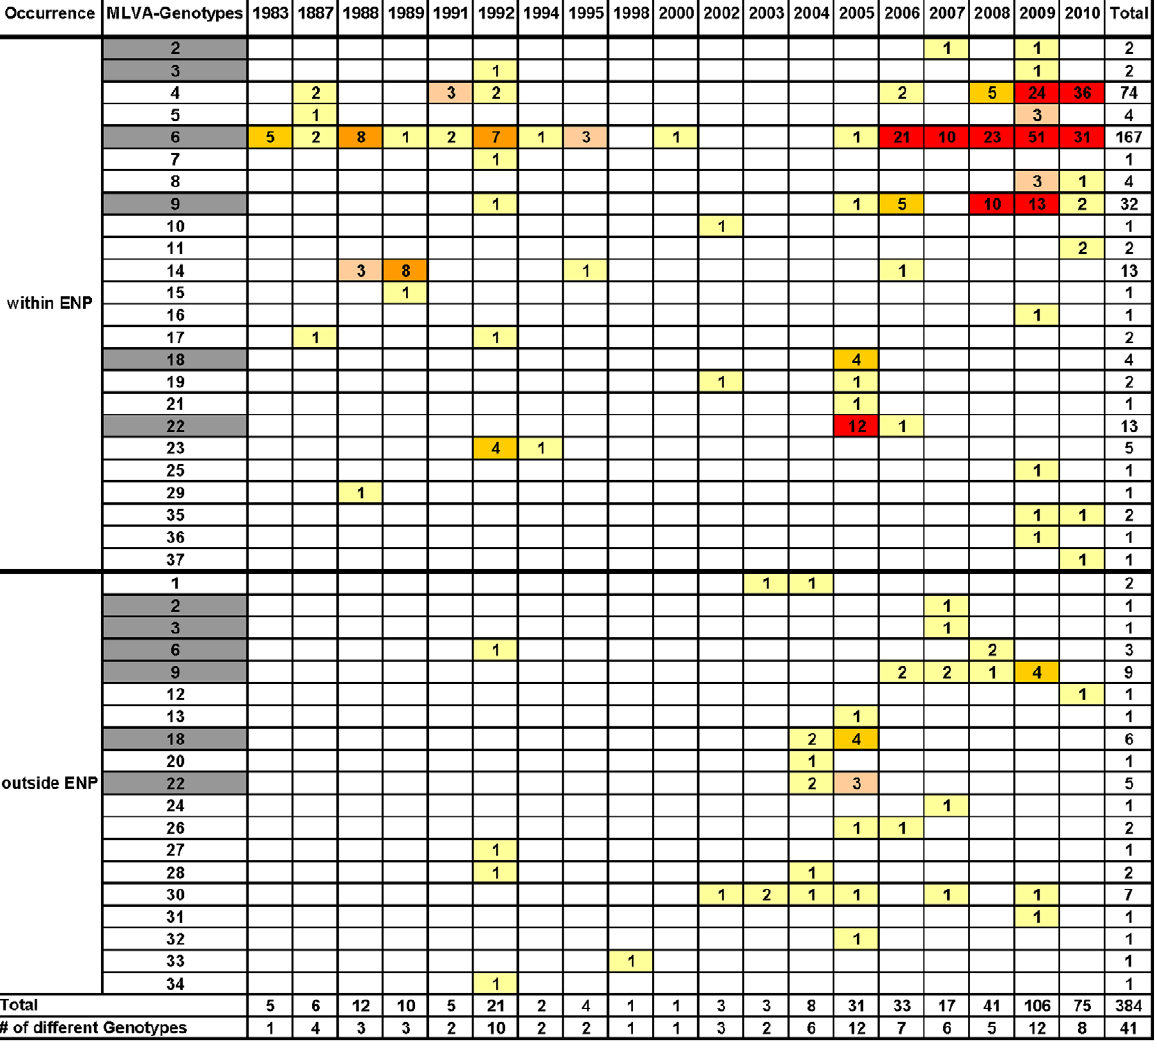
Figure 1. Distribution of genotypes isolated by year. The total number of isolates per year and per GT. GTs 2, 3, 6, 9, 18, and 22 (highlighted in grey) were found both within and outside the ENP.